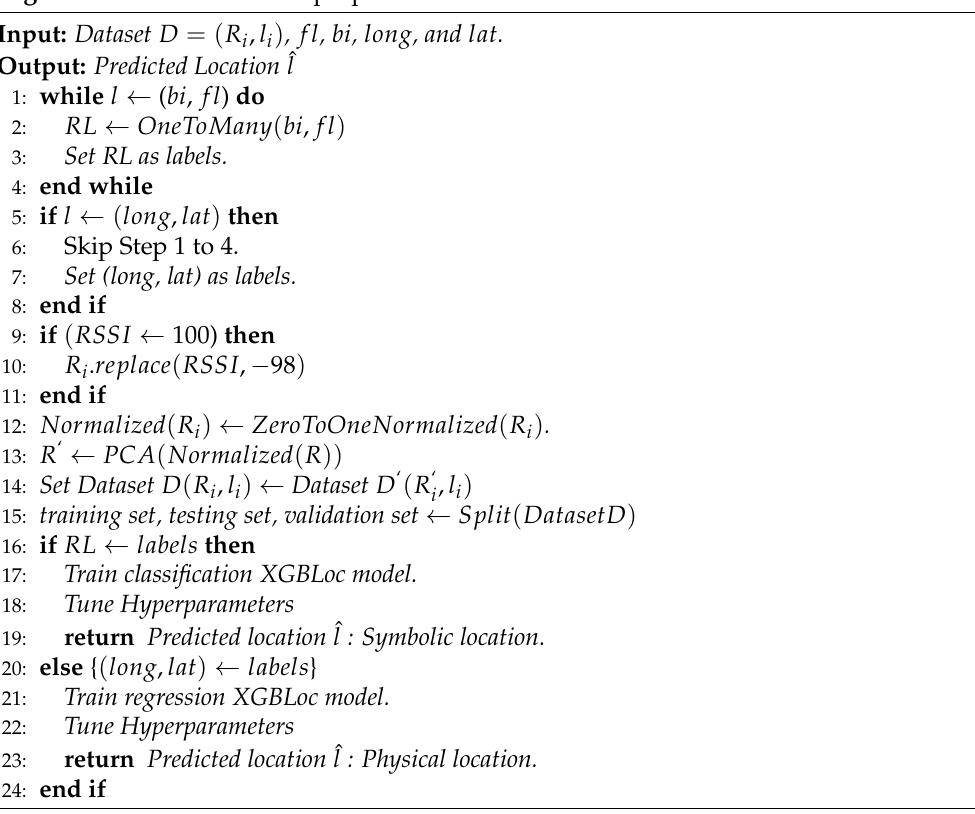
Figure 4. Explained variance ratio (EVR) vs number of principal components for the UJIIndoor- Loc dataset. Algorithm 1 Pseudo code of proposed XGBLoc